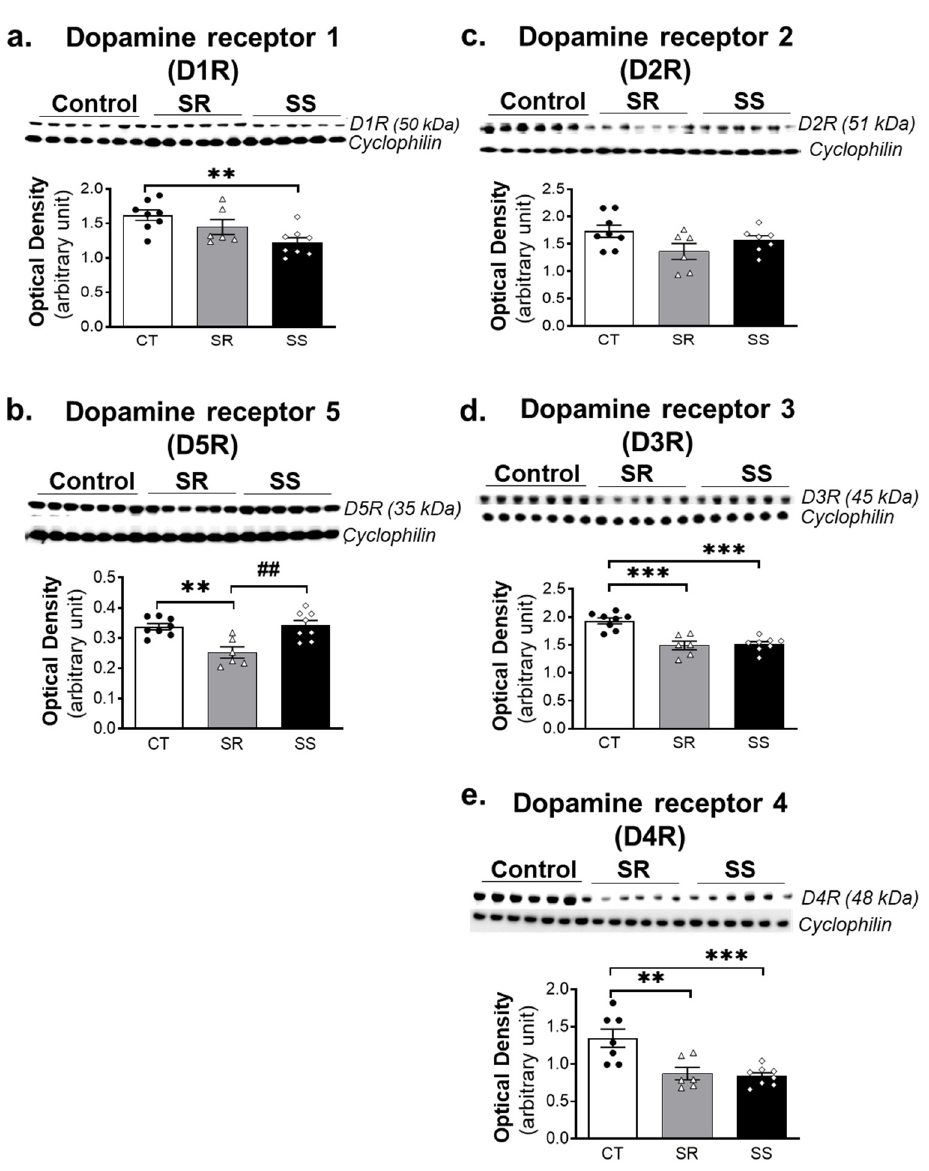
Figure 6. Protein levels of DA receptors are differentially impacted by METH SA in the dorsal striatum of rats. In the dorsal striatum, SS, but not SR, rats showed decreased D1R protein levels in comparison to the CT group ( a ). SR rats exhibited decreased D5R protein expression in comparison to CT and SS groups ( b ). There were no significant changes in D2R protein levels ( c ). Significant decreases in D3R and D4R protein levels were observed in both SR and SS rats ( d , e ). For quantification, the protein levels of D1R, D2R, D3R, D4R and D5R were normalized to cyclophilin and then analyzed. All values represent means ± SEM (n = 6–7 rats per group). Key to statistics: ** p < 0.01, *** p < 0.001, comparison to control saline group; ## p < 0.01, comparison to SR groups. The statistical analysis was performed using one-way ANOVA and Tukey ′ s post hoc tests.